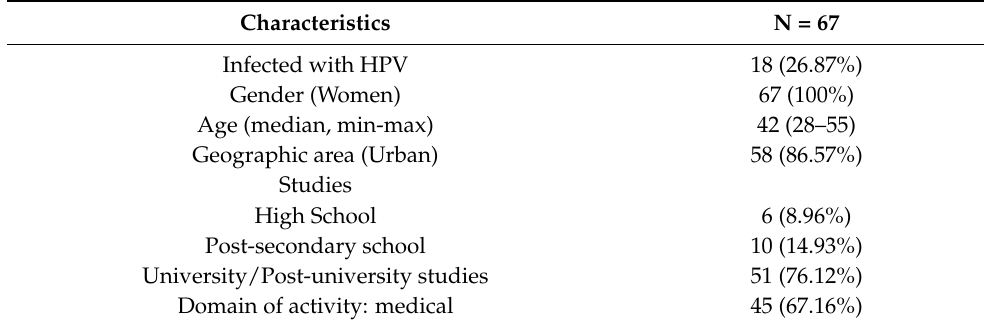
Table 4. Vaccination/infectious HPV status and socio-demographic and educational characteristics of HPV-vaccinated parents that vaccinated their children against HPV.